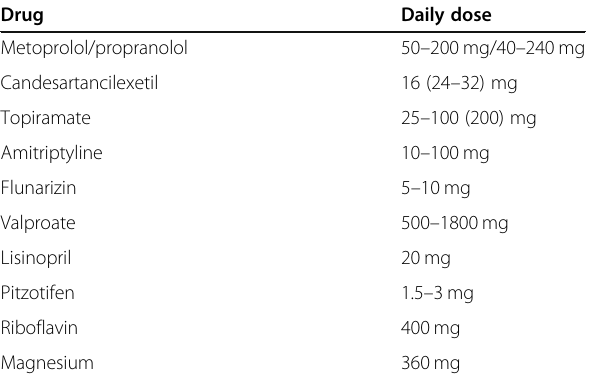
Table 8 Preventive medication against episodic migraine in a prioritized order and recommended doses for adult. Valproate should not be prescribed in women of childbearing age